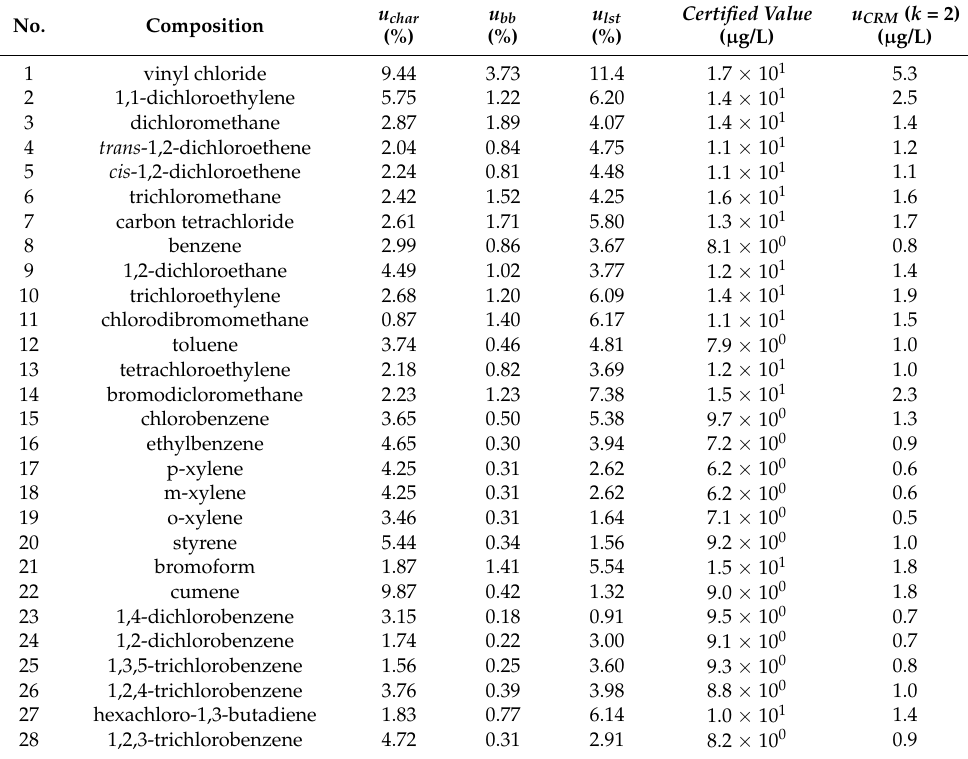
Table 5. Certified values and expended uncertainties of 28 VOCs in the water MCRM.